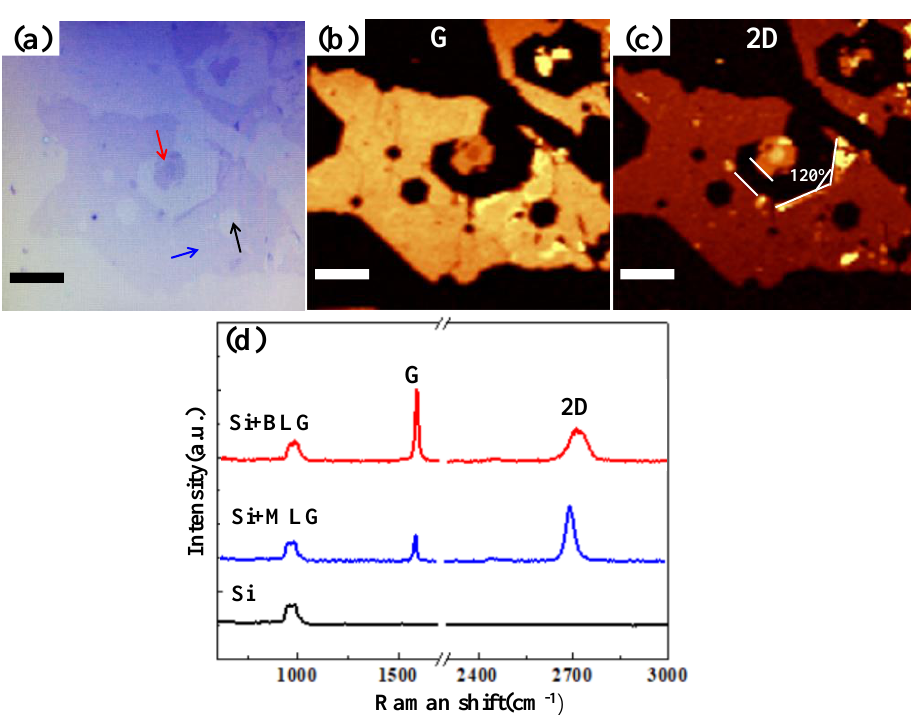
Figure 4. ( a ) Optical microscope image of the etched graphene domain after transferring to SiO 2 / Si substrate. ( b , c ) Raman G band map (1510 – 1650 cm − 1 ) and 2D band map (2650 – 2750 cm − 1 ). ( d ) Typical Raman spectra taken from the monolayer graphene (MLG) area, bilayer graphene (BLG) area, and etched hexagonal holes ( a ). All scale bars are 20 μm.